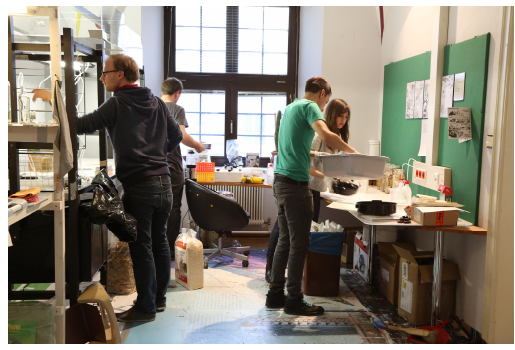
Figure 6. Project team working in the laboratory space.